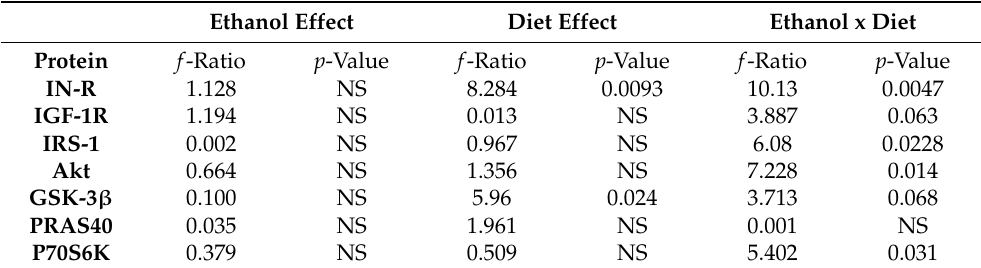
Table 3. Ethanol and Dietary Protein Effects on Akt-Pathway Proteins.